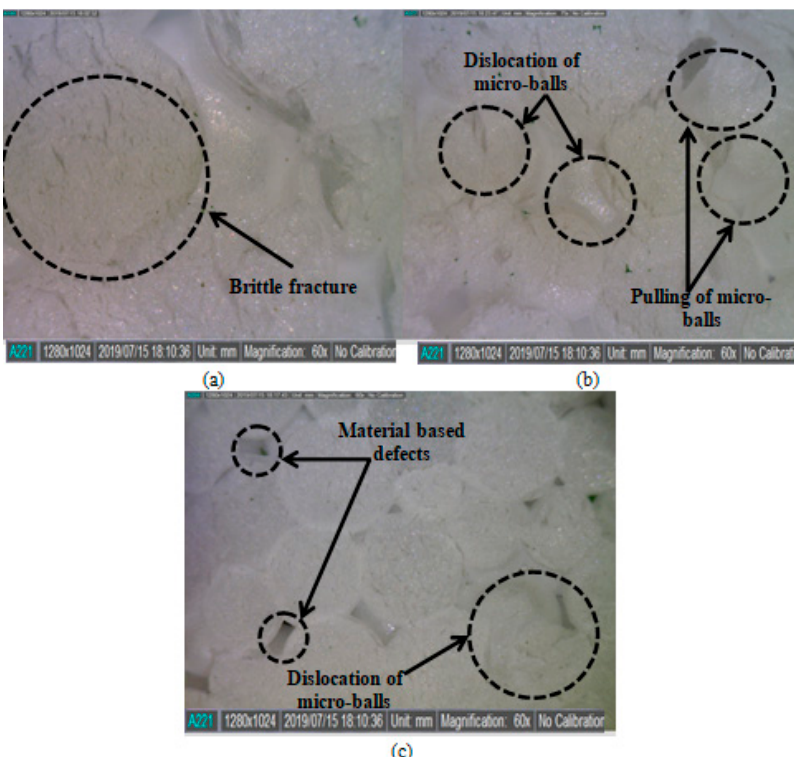
Figure 5. Surface morphology of machined EPS at ( a ) 1500 rpm, ( b ) 1700 rpm, and ( c ) 2000 rpm.